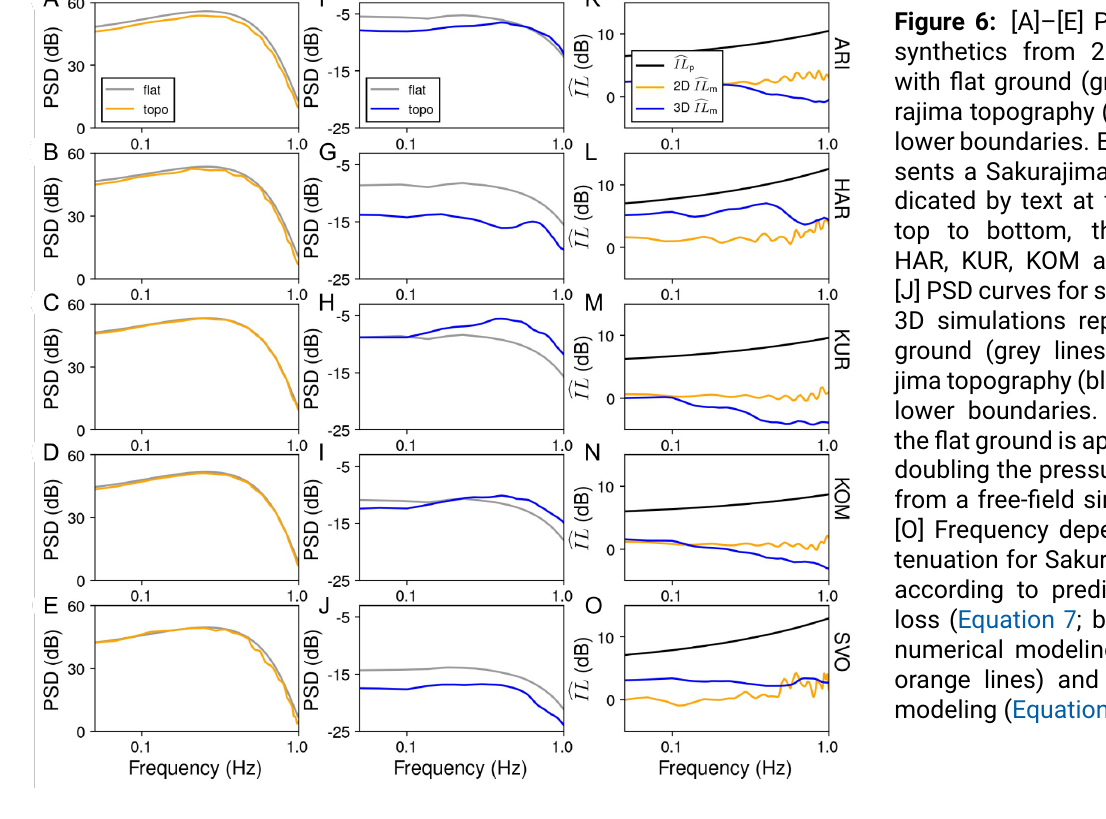
Figure 6: [A]–[E] PSD curves for synthetics from 2D simulations with flat ground (grey) and Saku- rajima topography (orange) at the lower boundaries. Each row repre- sents a Sakurajima station as in- dicated by text at far right (from top to bottom, these are ARI, HAR, KUR, KOM and SVO). [F]– [J] PSD curves for synthetics from 3D simulations representing flat ground (grey lines) and Sakura- jima topography (blue lines) at the lower boundaries. In this case the flat ground is approximated by doubling the pressure amplitudes from a free-field simulation. [K]– [O] Frequency dependence of at- tenuation for Sakurajima stations according to predicted insertion loss (Equation 7; black lines), 2D numerical modeling (Equation 8; orange lines) and 3D numerical modeling (Equation 8; blue